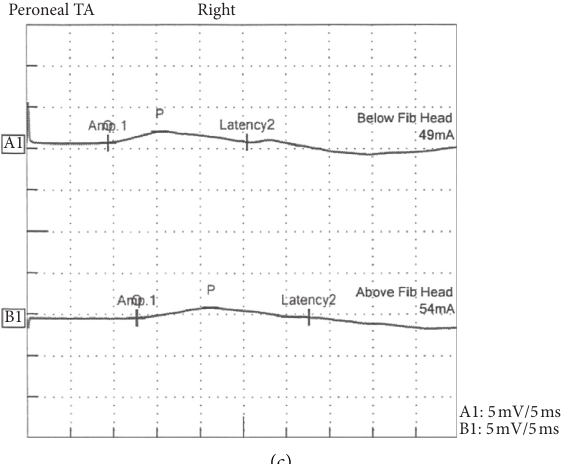
Figure 2: Nerve conduction study (NCS). Prolonged motor latency and reduced compound motor action potential (CMAP) amplitudes are noted and are shown in the median (a), ulnar (b), and peroneal (c)